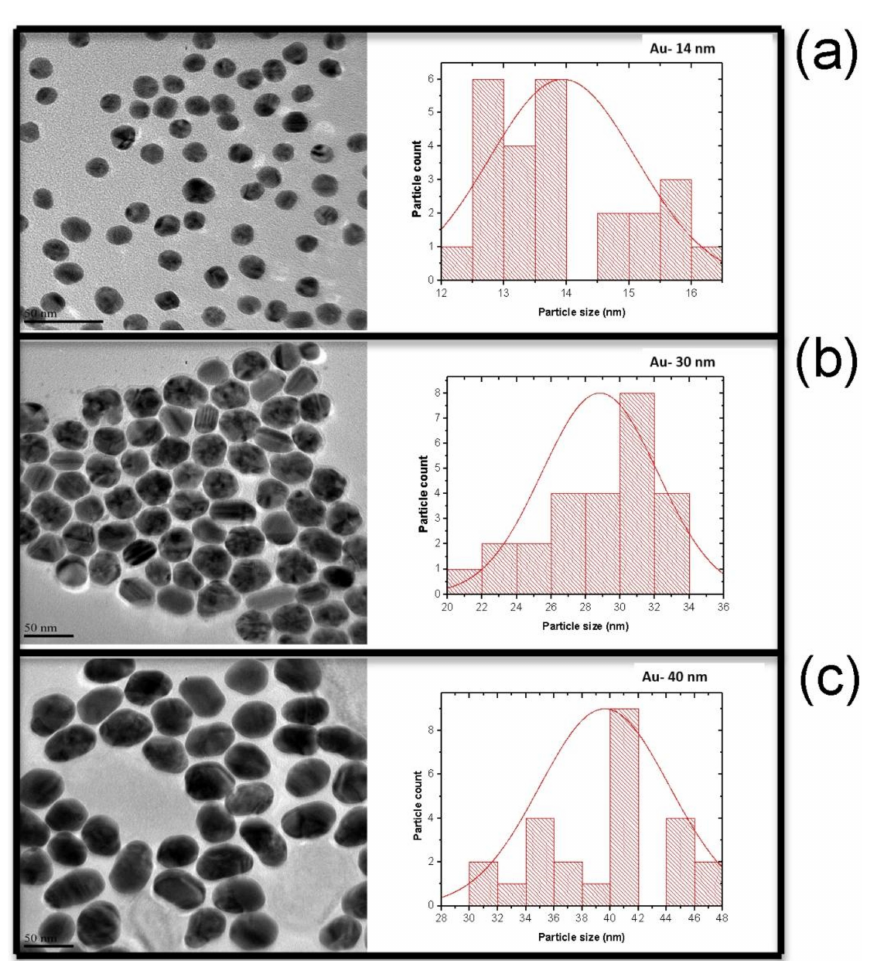
Figure 4. The transmission electron microscope images and size distribution histograms of AuNP samples synthesized with ( a ) 0.7, ( b ) 0.5 and ( c ) 0.2 citrate salt/gold salt